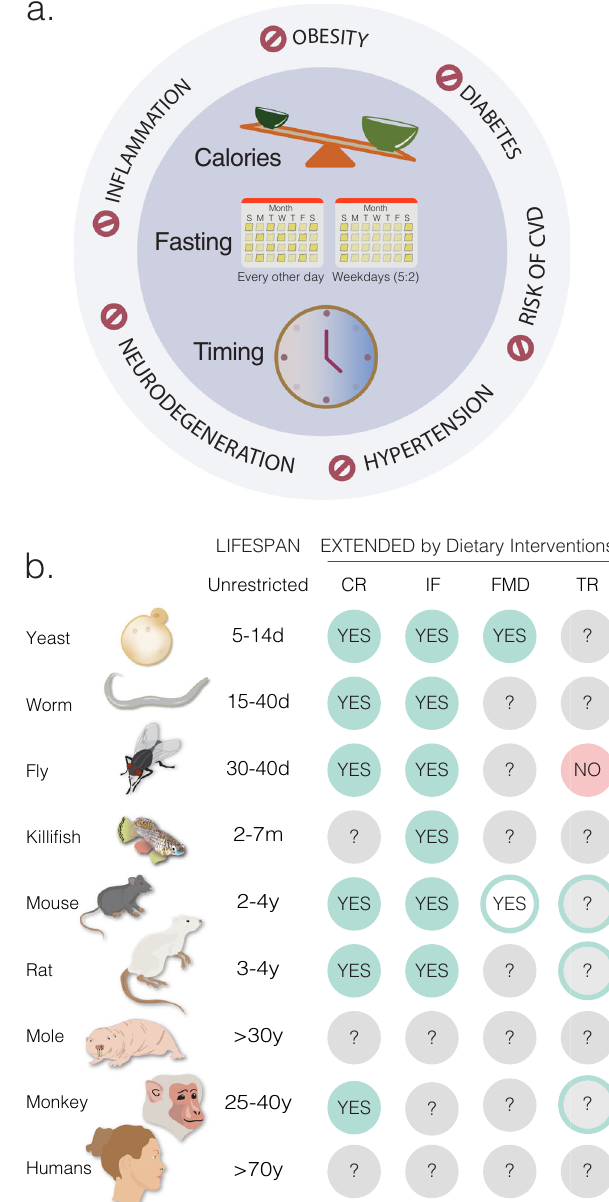
species by reducing the risk for obesity, diabetes, cardiovascular disease (CVD), hypertension, neurodegeneration, and in fl ammation. Although these bene fi ts have been associated with a reduction in the number of calories consumed, extending fasting periods, and restricting the timing of food intake, the individual contribution of these factors remains unknown, since classical dietary restriction protocols often combines one or more of these parameters. b Dietary restriction extends lifespan in most model organisms used in aging research. Green circles labeled as “ YES ” represent dietary interventions that increase both maximum and median lifespan. Green circles with white centers labeled as “ YES ” represent the extension of median but not maximum lifespan. Red circles labeled as “ NO ” refer interventions that have no effect on median or maximum lifespan. Gray circles labeled as “ ? ” indicate conditions that have not yet been